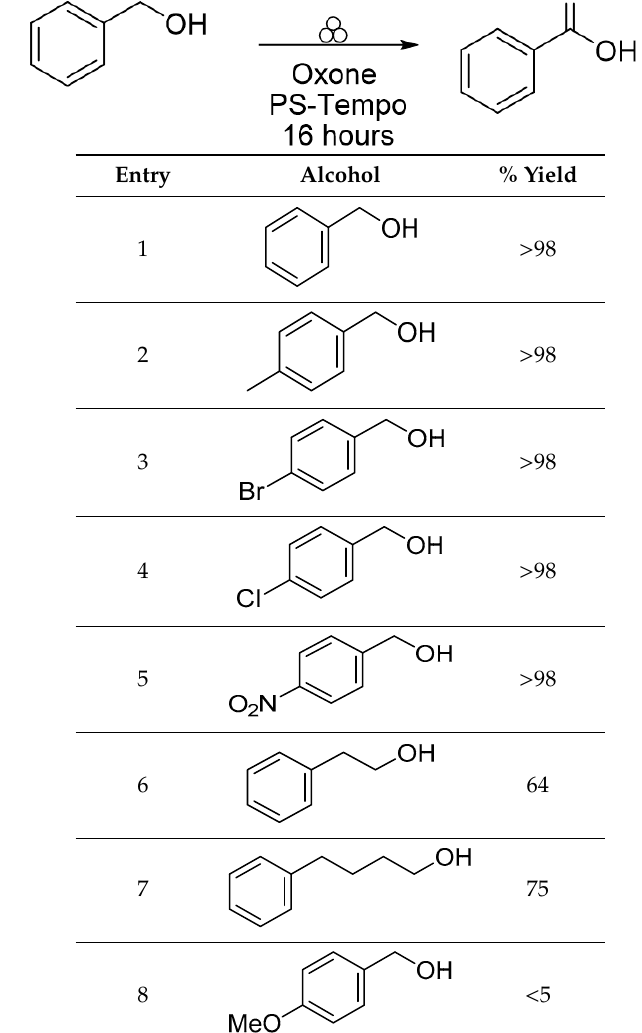
Table 1. Oxidation of alcohols to carboxylic acids with polymer-supported TEMPO.